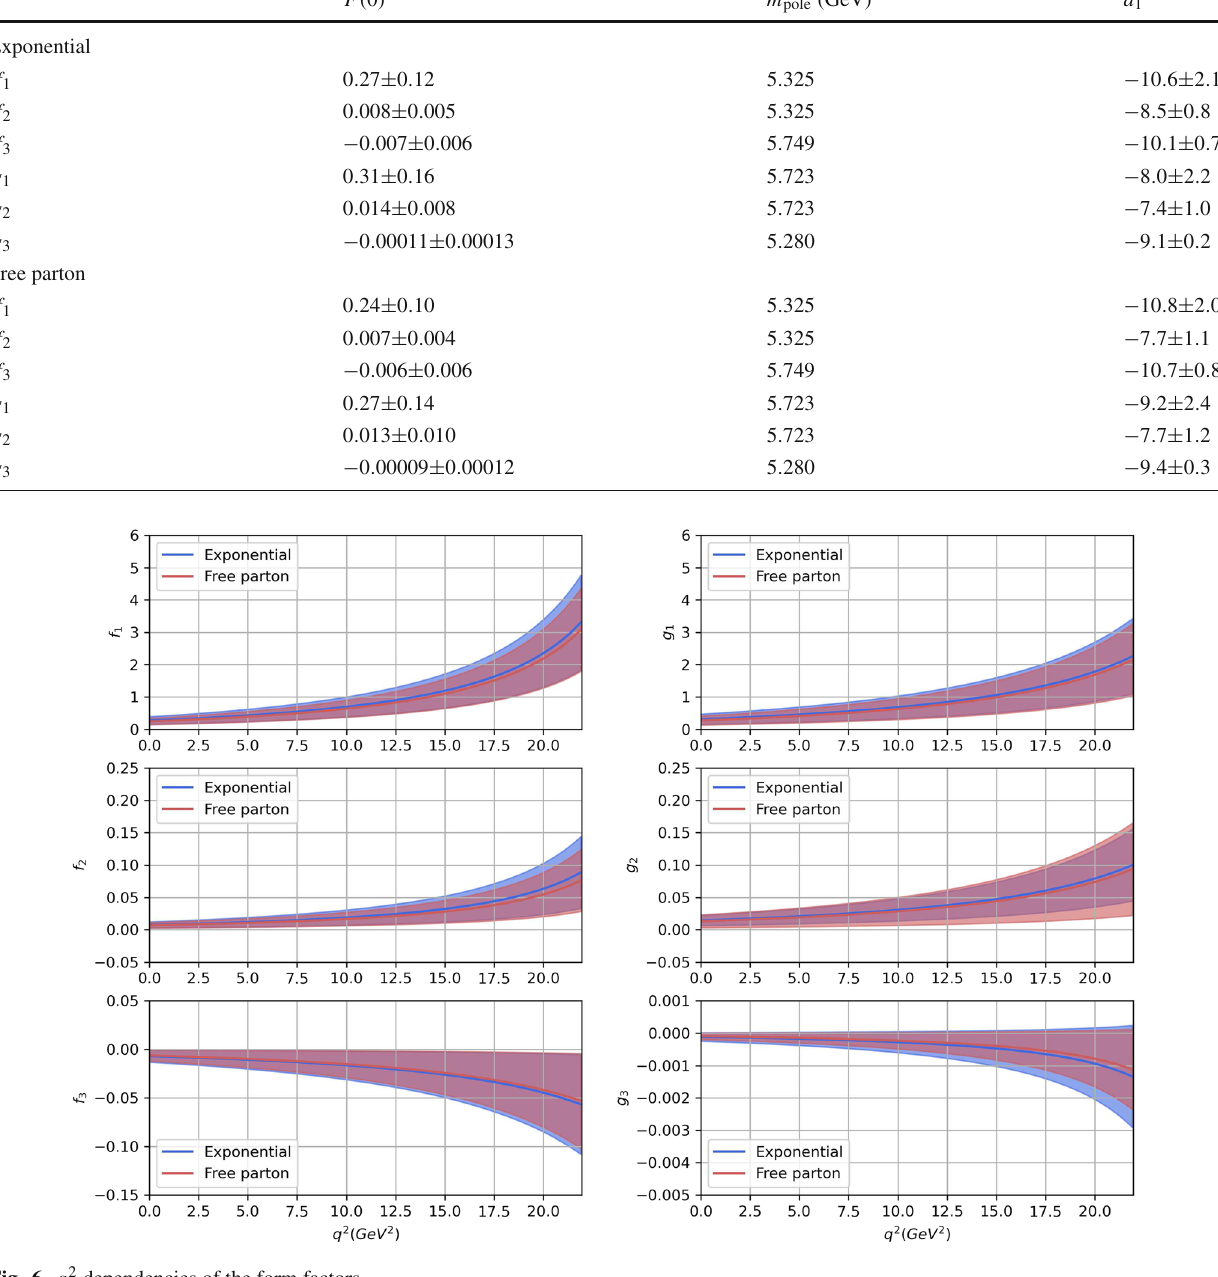
Fig. 6 q 2 dependencies of the form factors